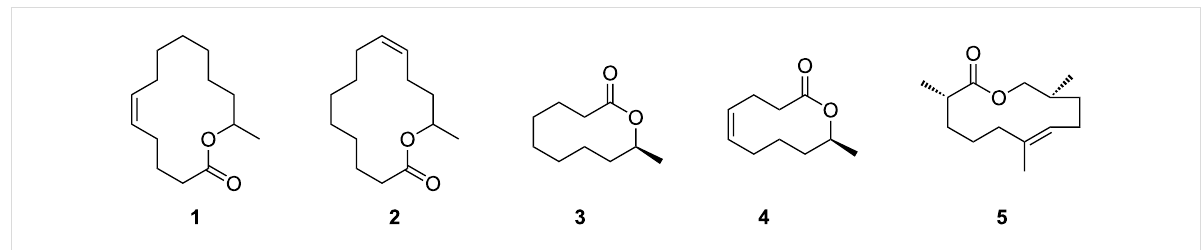
Figure 1: Macrolactones produced in scent glands of frogs: ( Z )-Tetradec-5-en-13-olide ( 1 ) or ( Z )-tetradec-9-en-13-olide ( 2 ), phoracantolide I ( 3 ), phoracantolide J ( 4 ), gephyromantolide A ( 5 ).